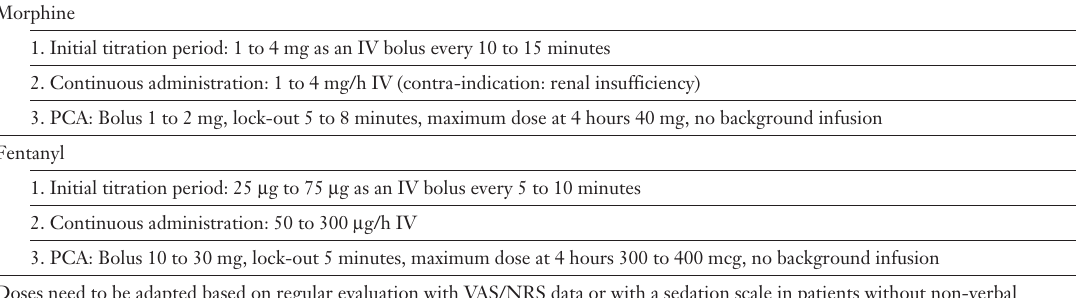
Table 2 Doses and adverse effects of the most frequently used opioids in critically ill